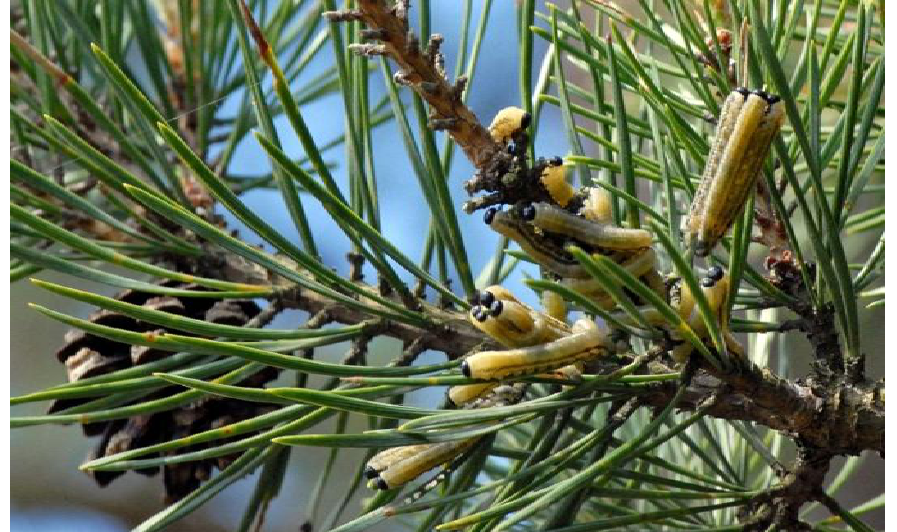
Figure 1. Gregariousness or group-living is typical for outbreak species among needle-eating lepidopterans and sawflies, here represented by the European pine sawfly, Neodiprion sertifer